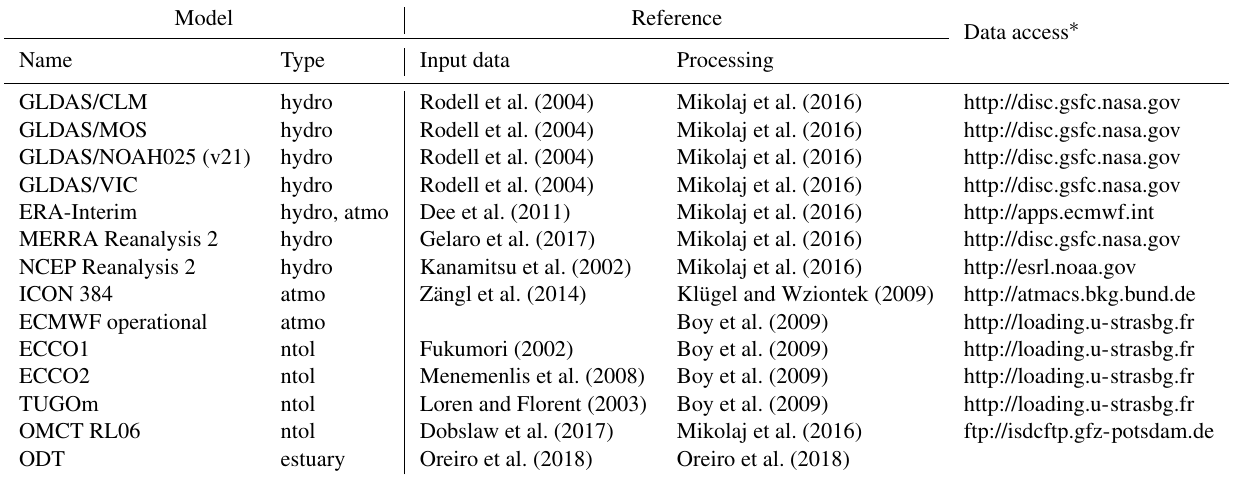
Table 4. Large-scale gravity models for atmospheric (atmo), hydrological (hydro), non-tidal ocean (ntol), and estuary loading effects.